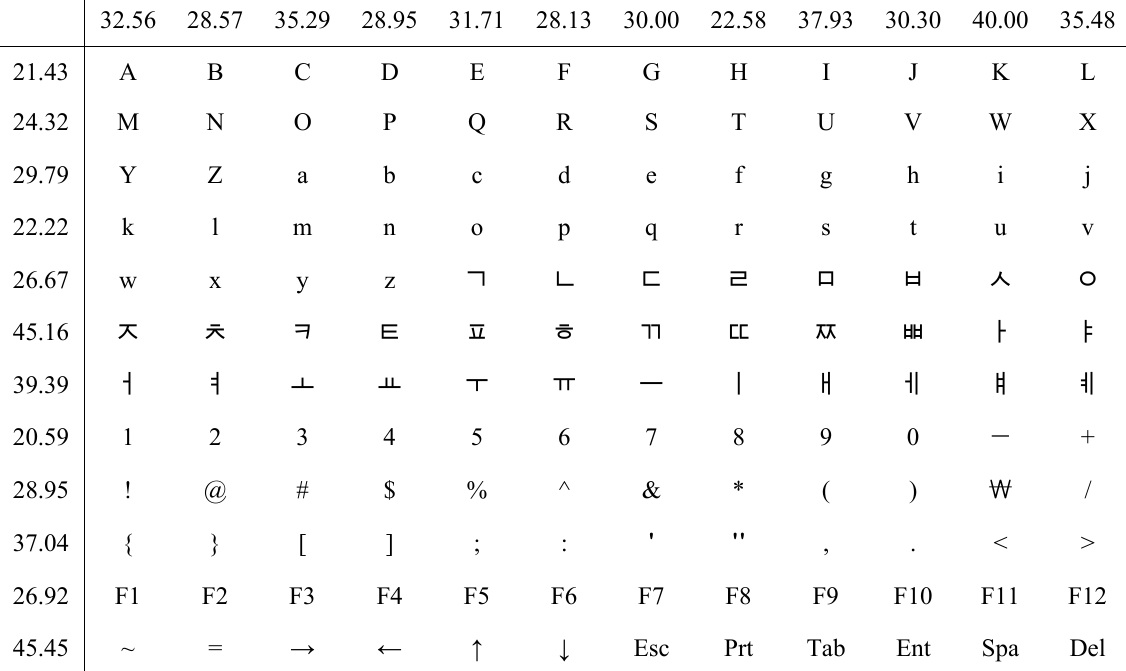
Table 4. Horizontal and vertical accuracies using only EEG signals (unit: %).